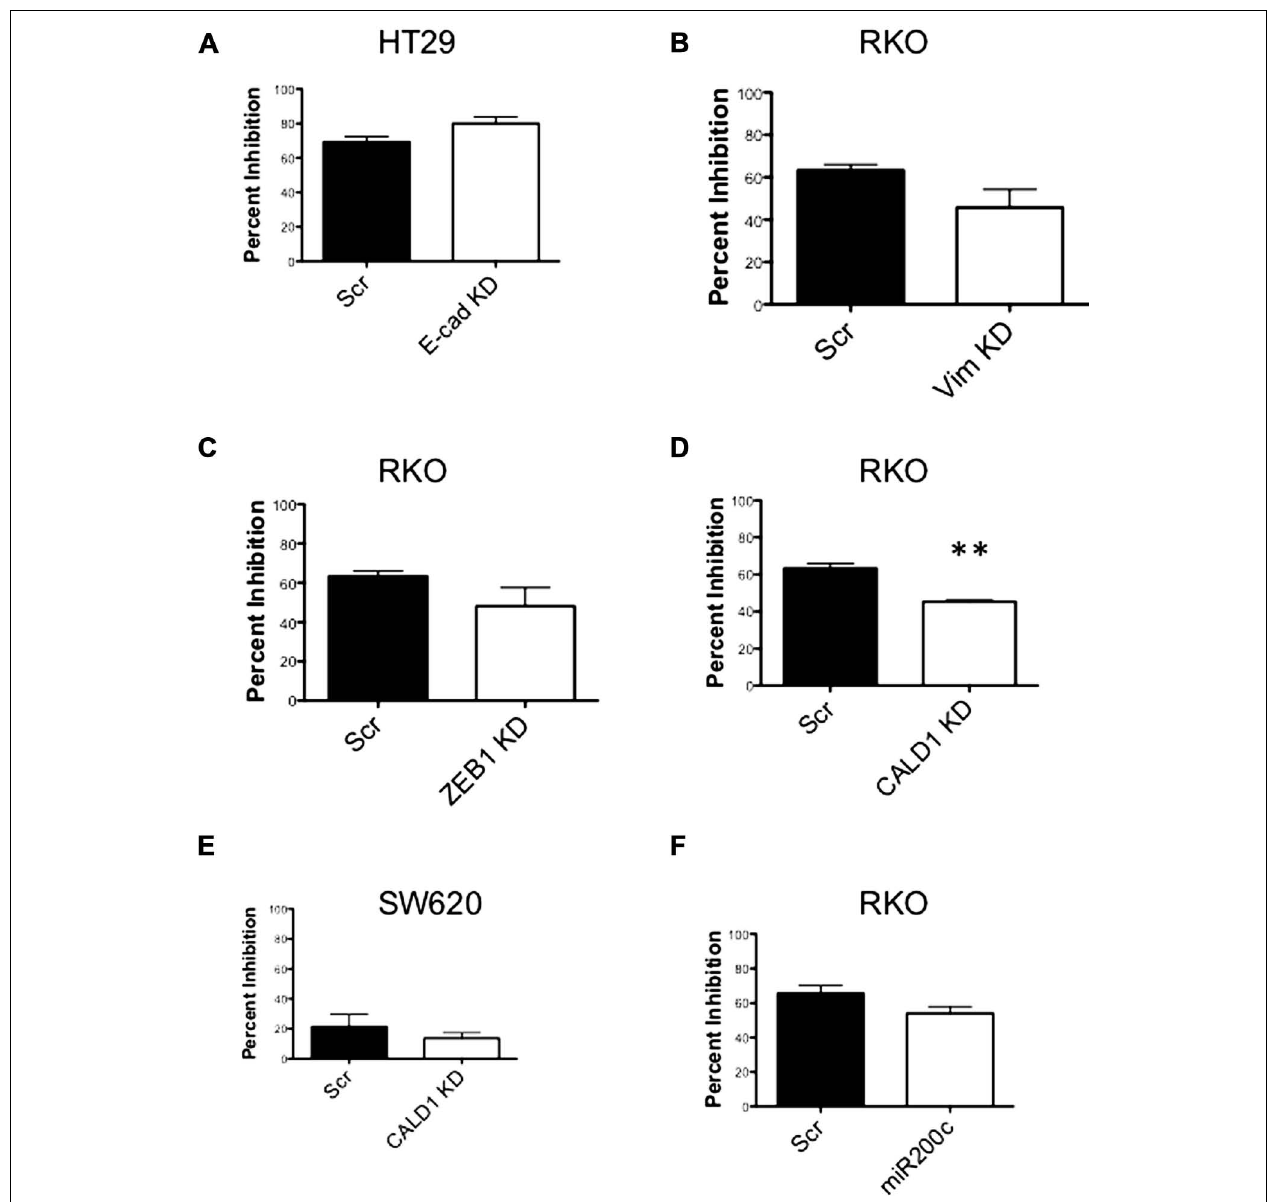
FIGURE 7 | Proliferation effects of knockdown of EMT-related genes. (A–E) Transfected cell lines with EMT-related genes knocked down exposed to varying concentrations of PF-3758309. Proliferation by